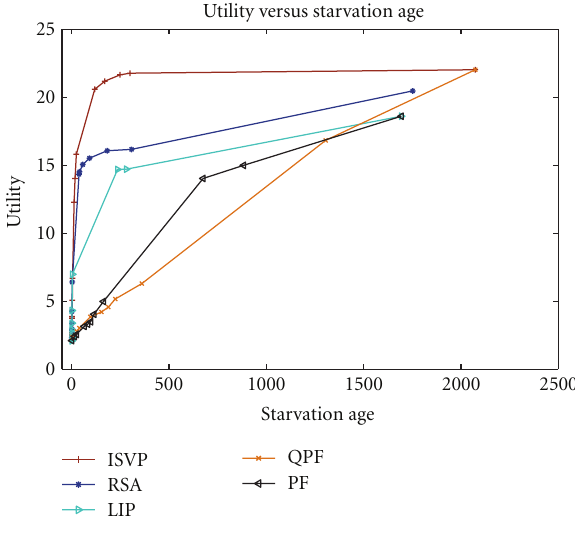
Figure 8: Utility ( (cid:26) Ψ ) versus starvation age ( (cid:26) χ ).